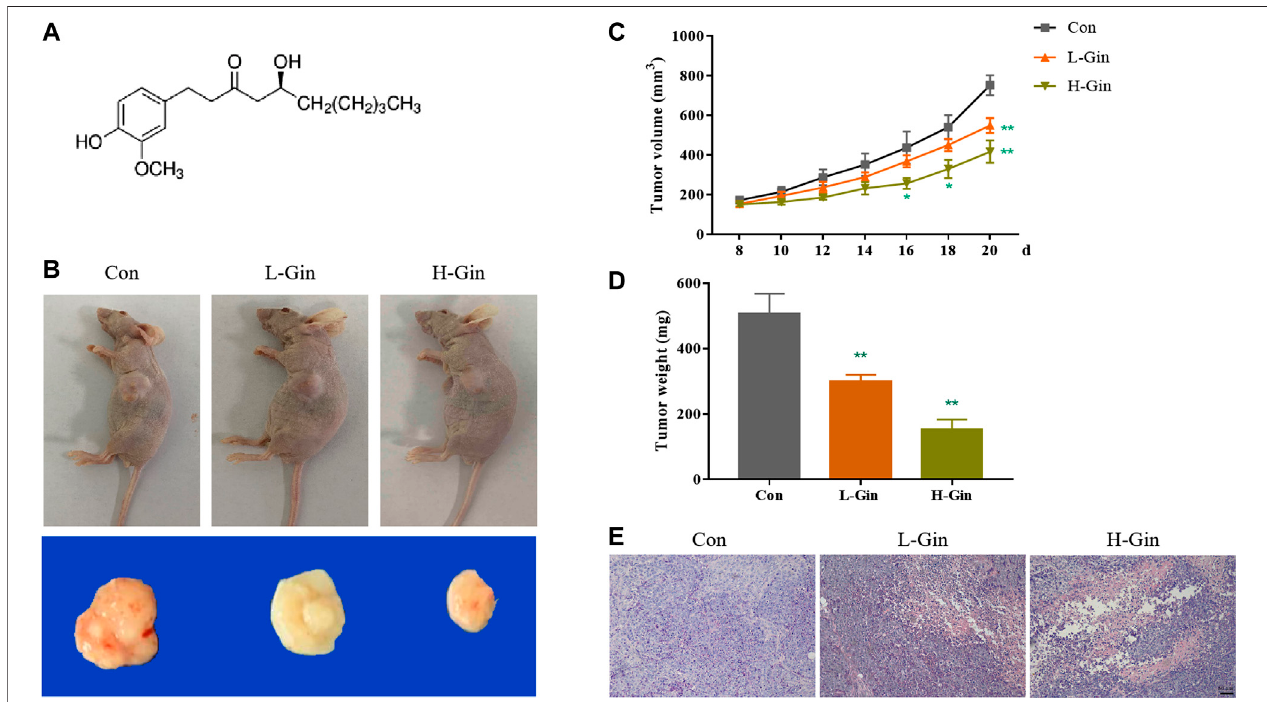
FIGURE1| 6-Gingerolsuppresses growth oftumor. (A) Chemical structure of6-Gingerol; (B) The pictures oftumor massesinnude mice; (C) 6-Gingerolinhibited theincreaseoftumorvolumeinnudemice; (D) 6-Gingerolinhibitedtheincreaseoftumorweightinnudemice; (E) Thehistologicalfeaturesoftumortissues.Con:control, L-Gin:0.25 mg/kg/day6-Gingerol,H-Gin:0.5 mg/kg/day6-Gingerol.Comparedwiththecontrolgroup,* p < 0.05,** p < 0.01.Dataareexpressedasmean ± SD( n (cid:2) 8).